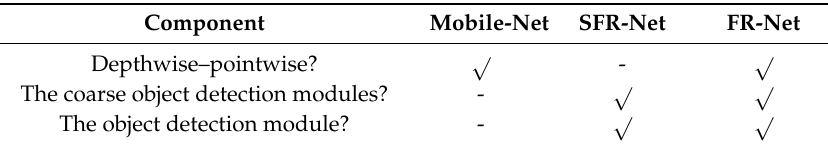
Table 4. Models of various designs.